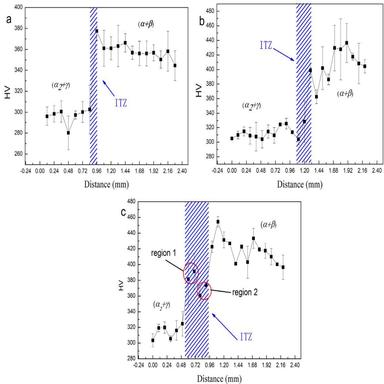
Micro-hardness profiles of the cross-section of the 0.5, 1, and 2 mm overlap specimens: (a) 0.5 mm, (b) 1.0 mm and (c) 2.0 mm.